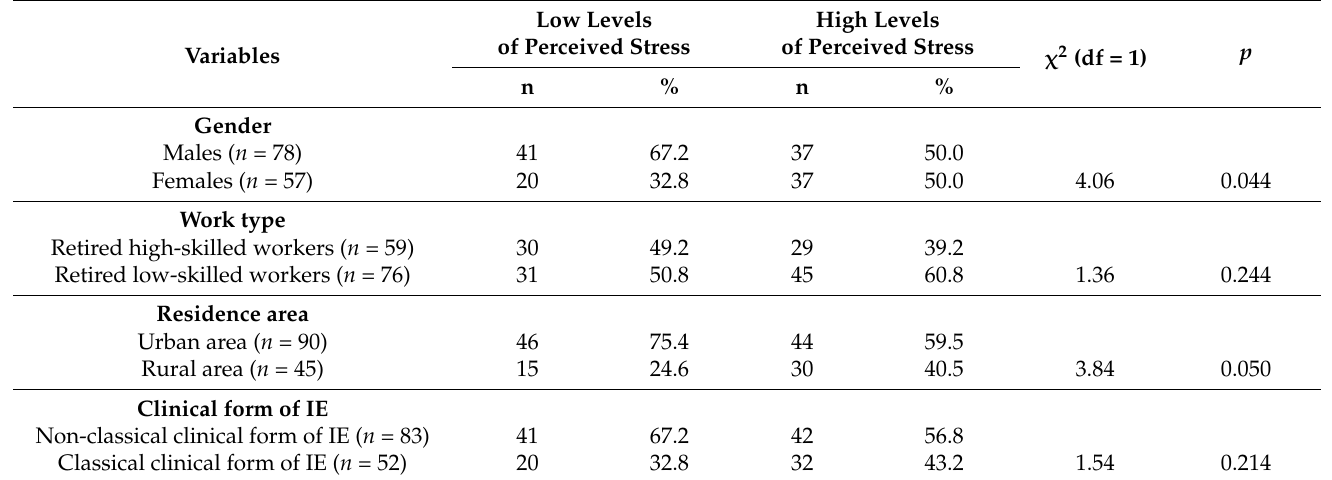
Table 2. The distribution of study variables between stress levels groups ( n =